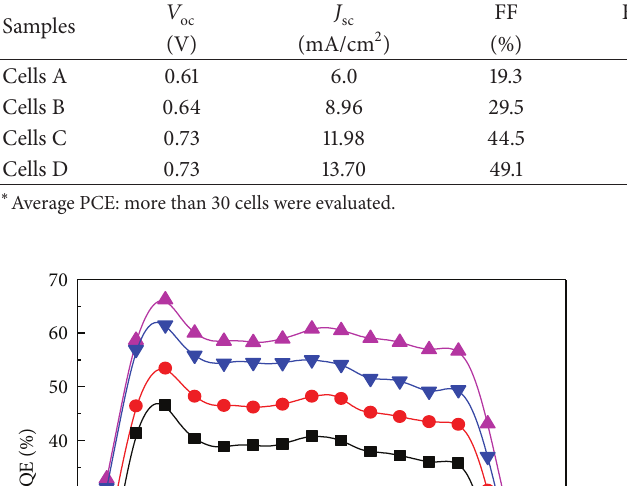
efficient photon-to-electron conversion. The EQE spectra of PSCs also demonstrate that PEDOT:PSS/LiF as anode buffer layer could play positive effect on charge carrier